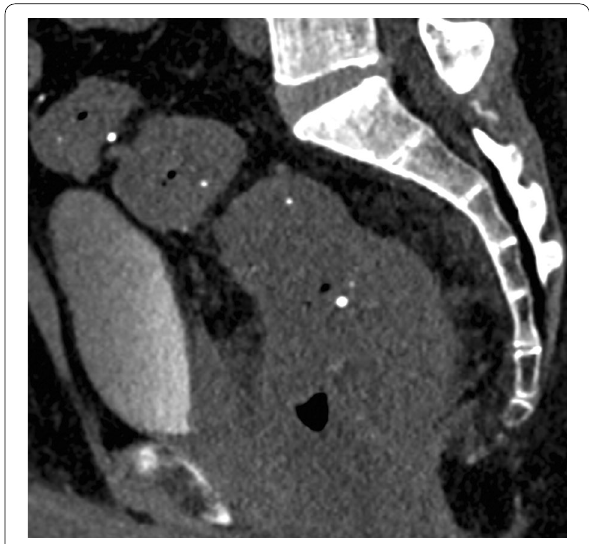
Fig. 3 The non-contrast sagittal CT image shows multiple round foci of calcification consistent with phleboliths